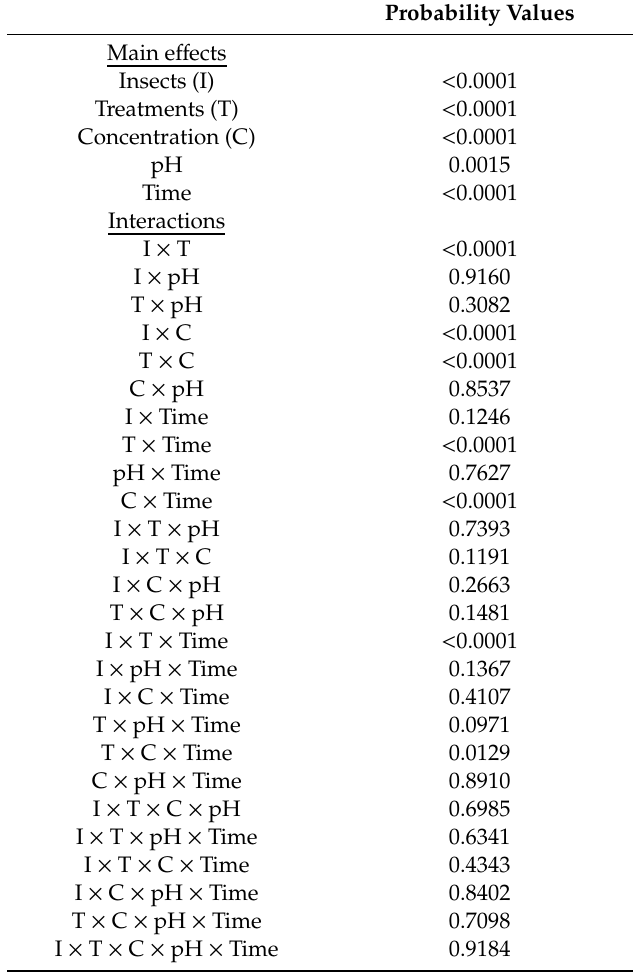
Table A1. Probability values for the e ff ects of insects (crickets and mealworms), treatments (meals, control hydrolysate and hydrolysate generated after HHP treatment of meals), concentration (0.5, 1.0 and 3.0% w / v ), pH (4.0, 5.5 and 7.0) and time (30, 60 and 90 min) on the emulsion stability